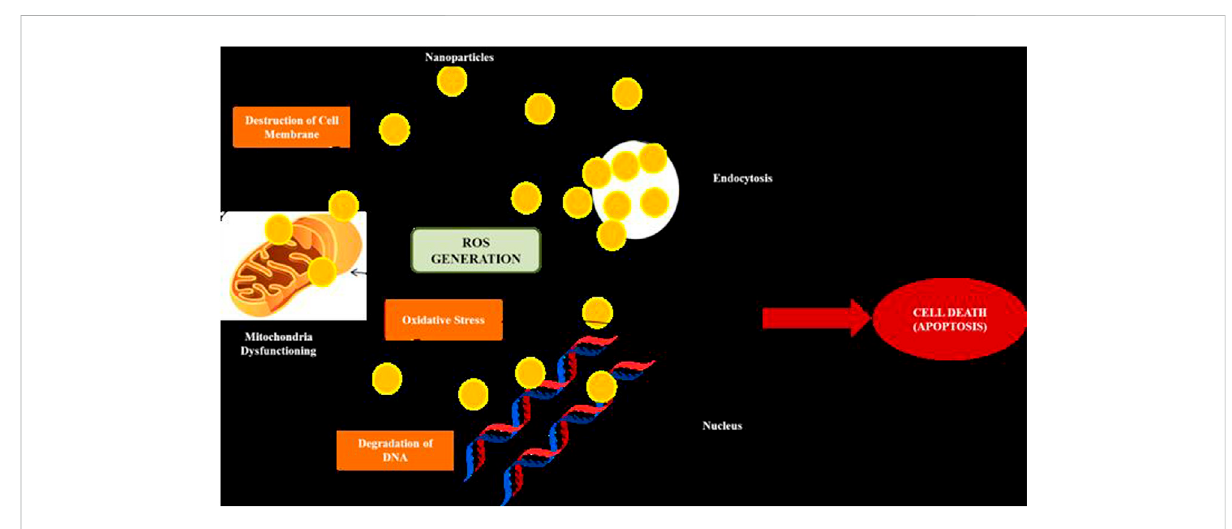
FIGURE 2 Mechanism of action of nanoparticles on cancer